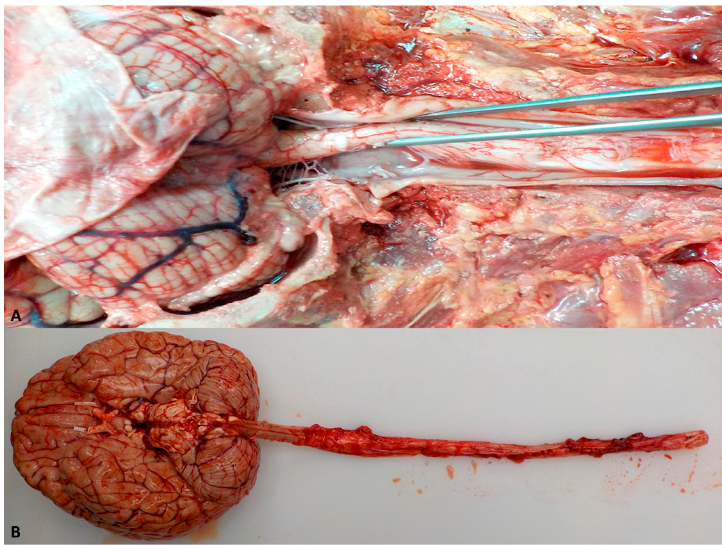
Figure 3. ( A ) Exposure of the cerebellum, spinal-medulla, and the spinal nerves. ( B ) Removal of the spinal cord with the brain.